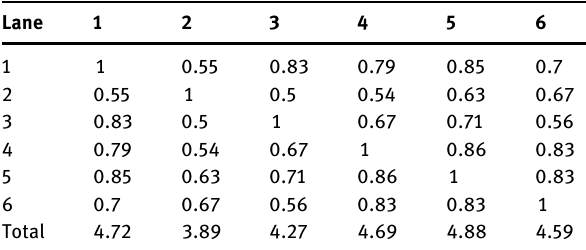
Table 4: Genetic similarity values among six wheat varieties in a matrix